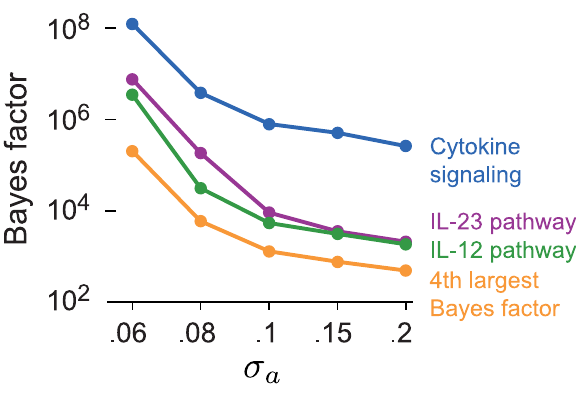
Figure 7. Top four BFs in CD for each setting of s a . In each case, the 3 largest BFs correspond, in order, to Cytokine signaling in immune system, IL23-mediated signaling events, and IL12-mediated signaling events (these are the top 3 pathways for CD in Figure 2). Pathway with fourth largest BF differs across settings of s a